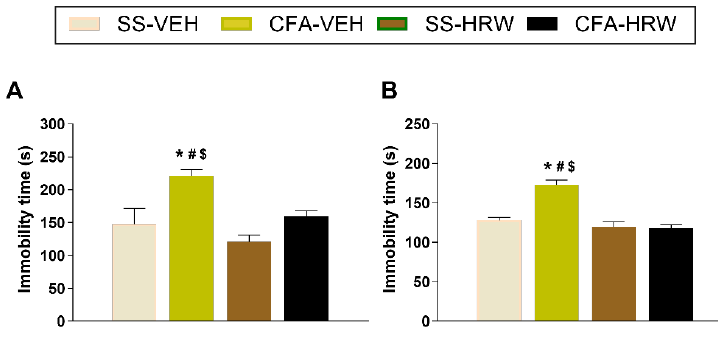
Figure 3. Treatment with HRW inhibited the depressive-like behaviors linked with chronic inflammatory pain. Immobility times (s) in the TST ( A ) and FST ( B ) at day 16 after CFA injection in animals intraperitoneally treated with HRW or VEH, injected at 2T per day for two consecutive days, are represented. The effects of HRW and VEH in SS-injected mice are also shown. For each test evaluated, * denotes significant differences vs. SS-injected mice treated with VEH, # vs. SS-injected mice treated with HRW, and $ vs. CFA-injected mice treated with HRW ( p < 0.05, one-way ANOVA and Student–Newman–Keuls test). Data are shown as mean values ± SEM; n = 8 animals for group.